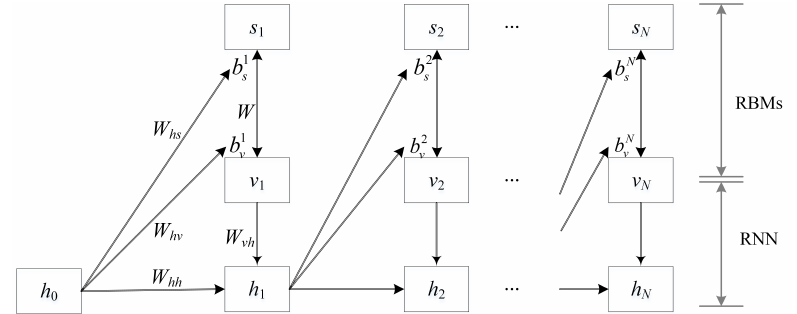
Figure 1. The graphical structure of